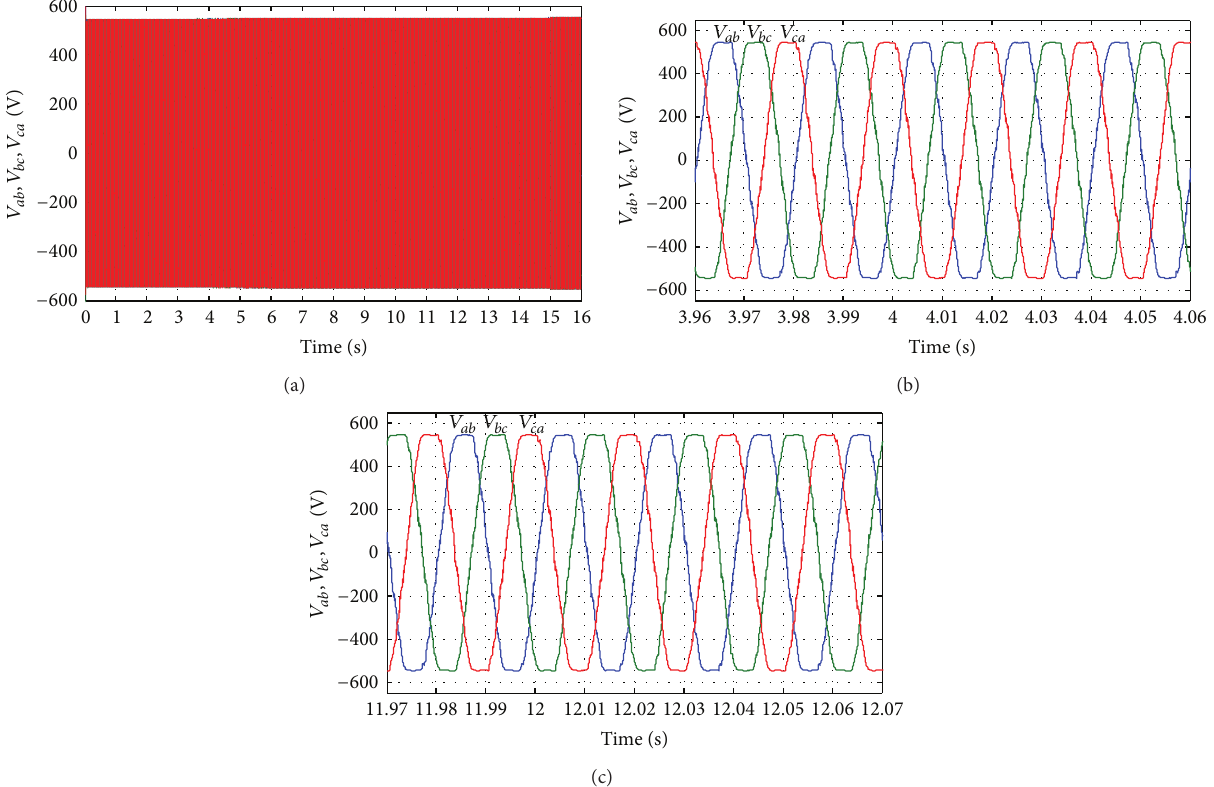
Figure 24: Output line voltage response with change in required load power. (a) Output line voltages throughout the full simulation time; (b) output line voltage when the load increases at simulation time from 3.96 s to 4.06 s; (c) output line voltage when the load decreases at simulation time from 11.97 s to 12.07 s.